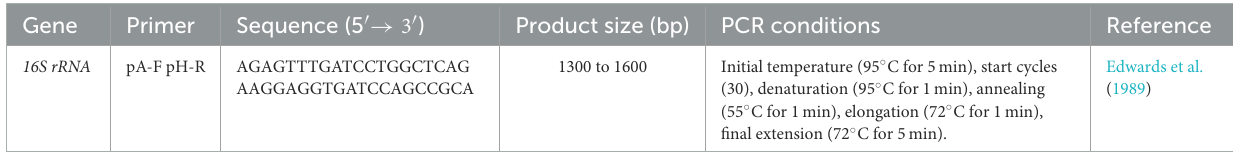
TABLE 1 Primer sequences used for 16S rRNA gene